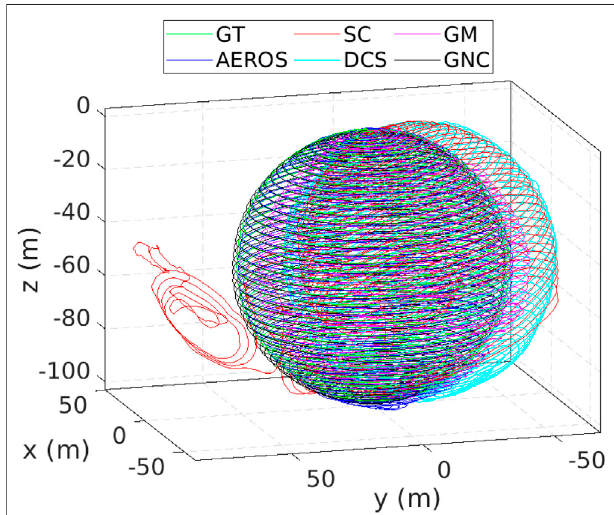
FIGURE 5 | Estimated trajectories compared to the ground truth (green) for the Sphere3500 dataset with 40 % outlier ratio. As can be seen, the SC approach was unable to reject some of the outliers resulting in global inconsistency. At this Monte-Carlo run, AEROS and GNC outperform the other